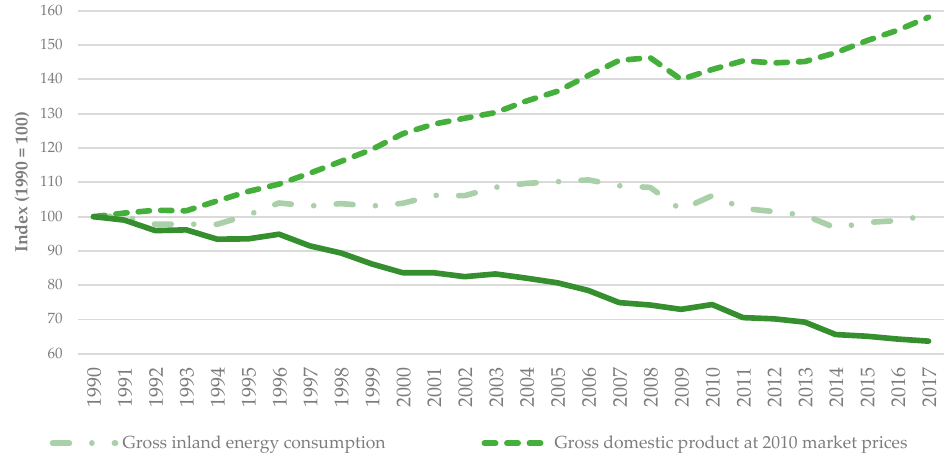
Figure 1. Trends in energy intensity, gross domestic product, and gross inland energy consumption in the European Union (created using data from [15]).